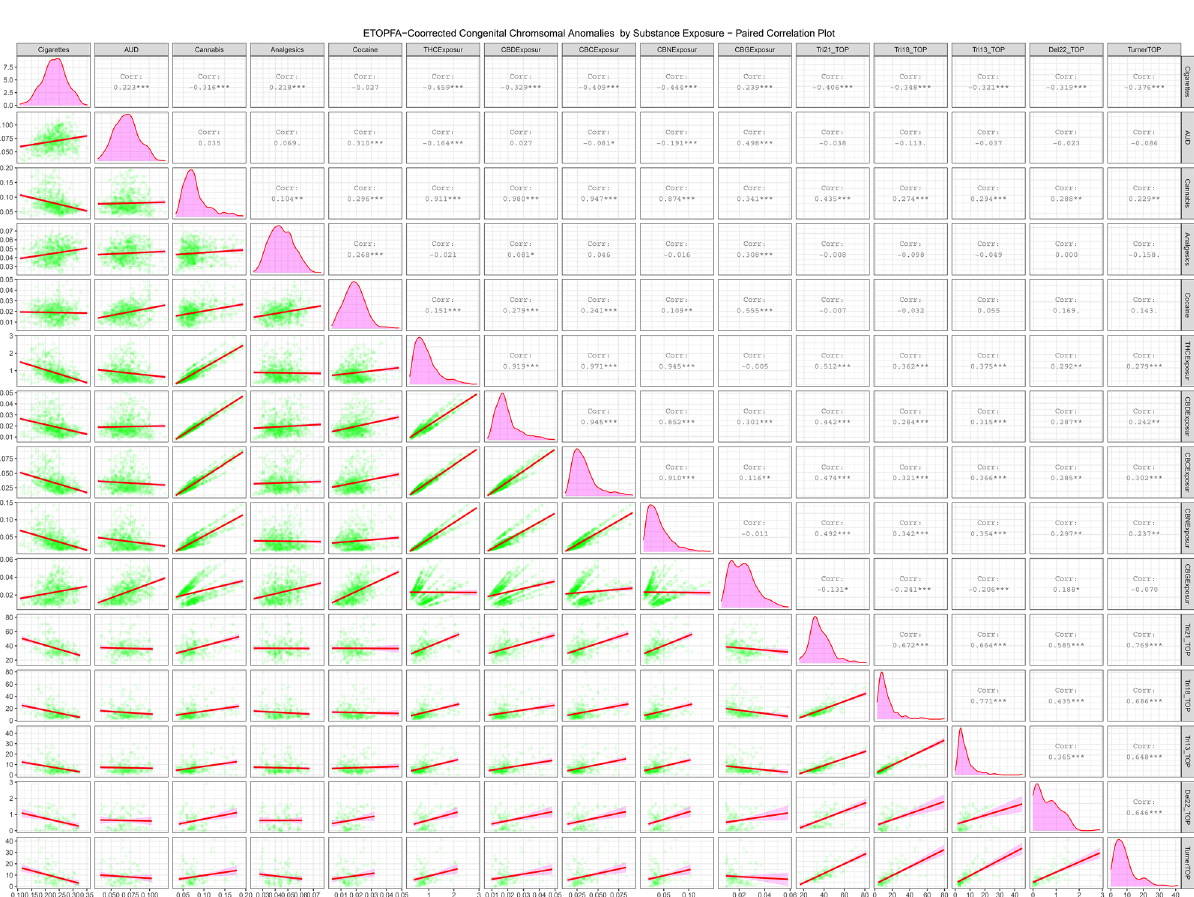
Figure 4. Paired scatterplot matrix for the covariates in the ETOPFACAR dataset. (Created in R-Studio version 1.3.1093 using ggpairs function from the GGally package version